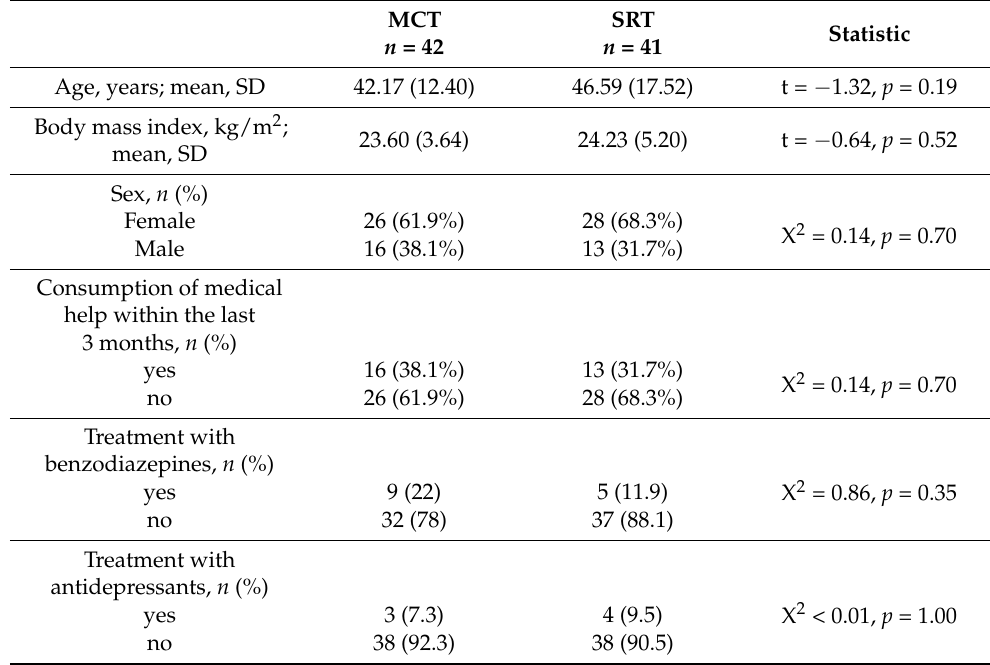
Table 1. Baseline characteristics used in analysis of prognostic and predictive factors of ISI change of 83 study participants with